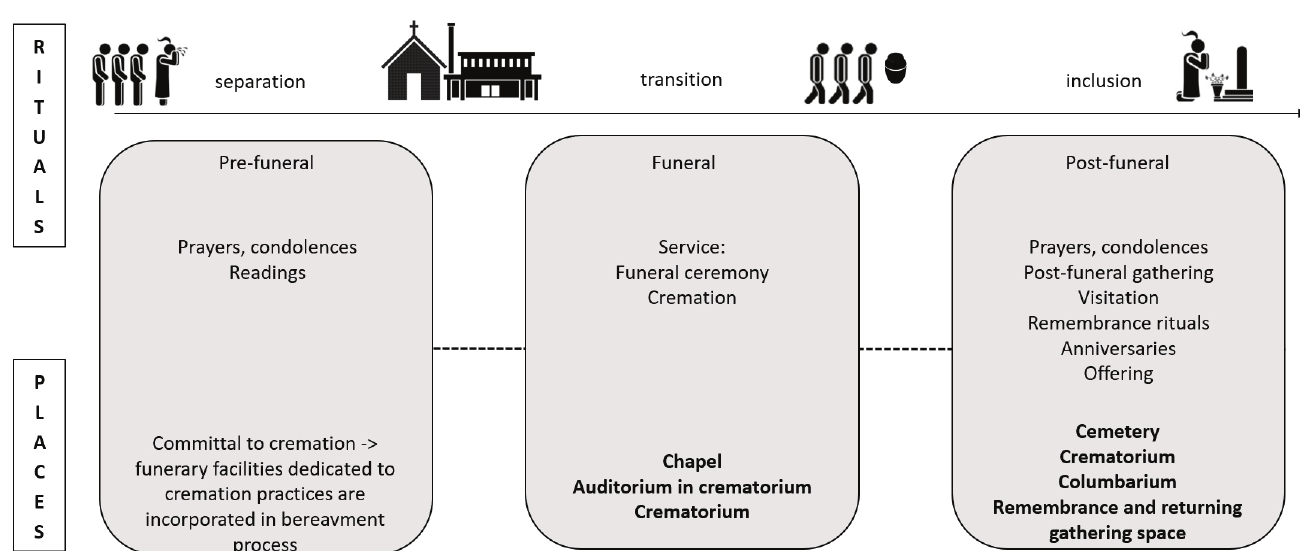
Figure 3.Funerary landscape and its multifaceted nature related to bereavement process and rituals. Own elaboration based on (Keddemann 2011; Pham